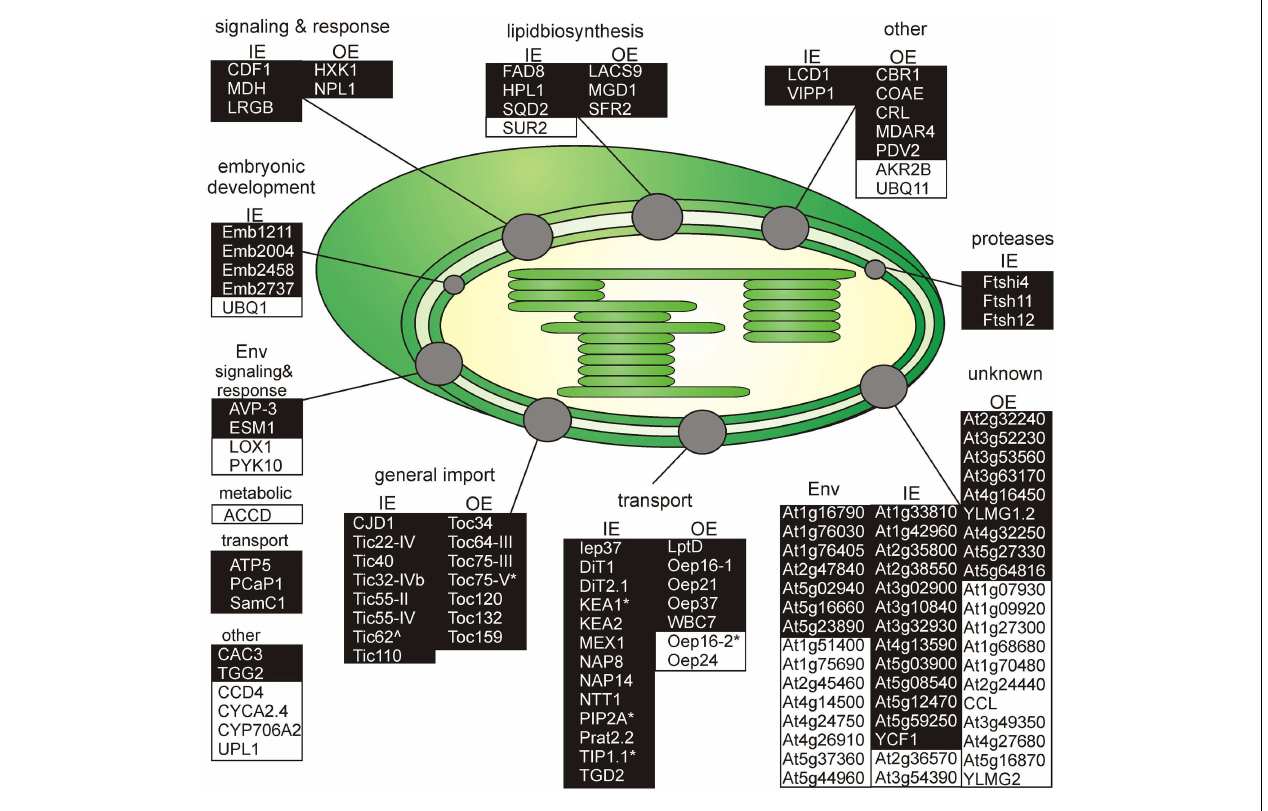
proteins with unknown function ( Table 6 ) are listed in a separated cluster. Black boxes indicate proteins of category I and white boxes proteins of category III ( Table 1 ). * Indicates not found in ENV but clearly localized to IE or OE known from literature. ∧ Indicates localized to IE or OE but only detected with one